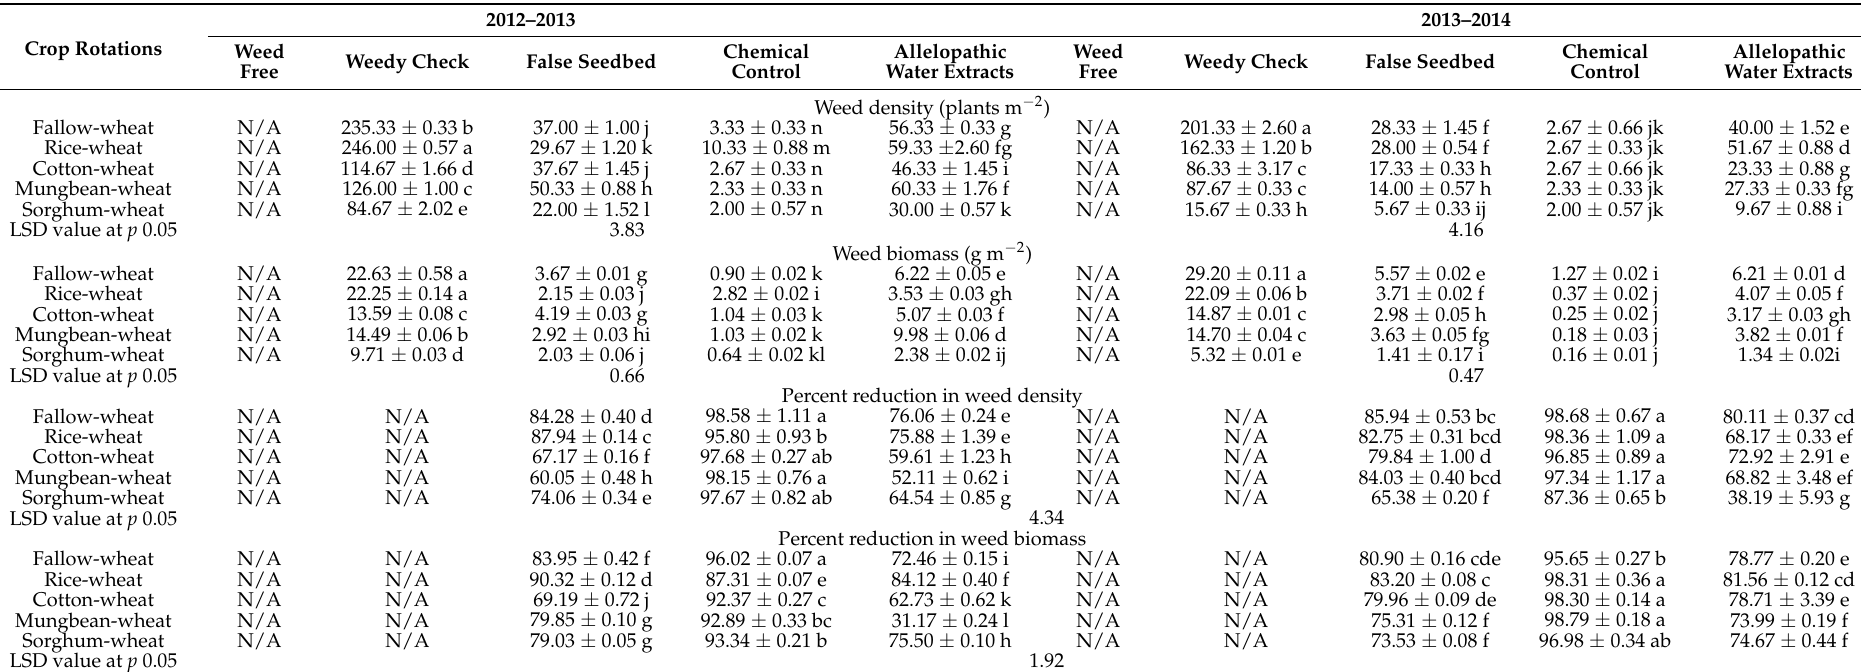
Table 6. Effect of different crop rotations and weed managing techniques on total weed density (m − 2 ) and biomass (g m − 2 ) and percentage reduction in weed density and biomass in wheat